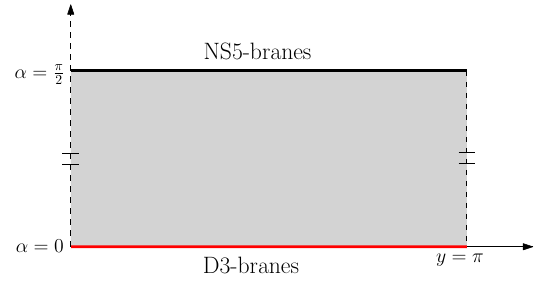
Figure 1 . Annulus associated to the